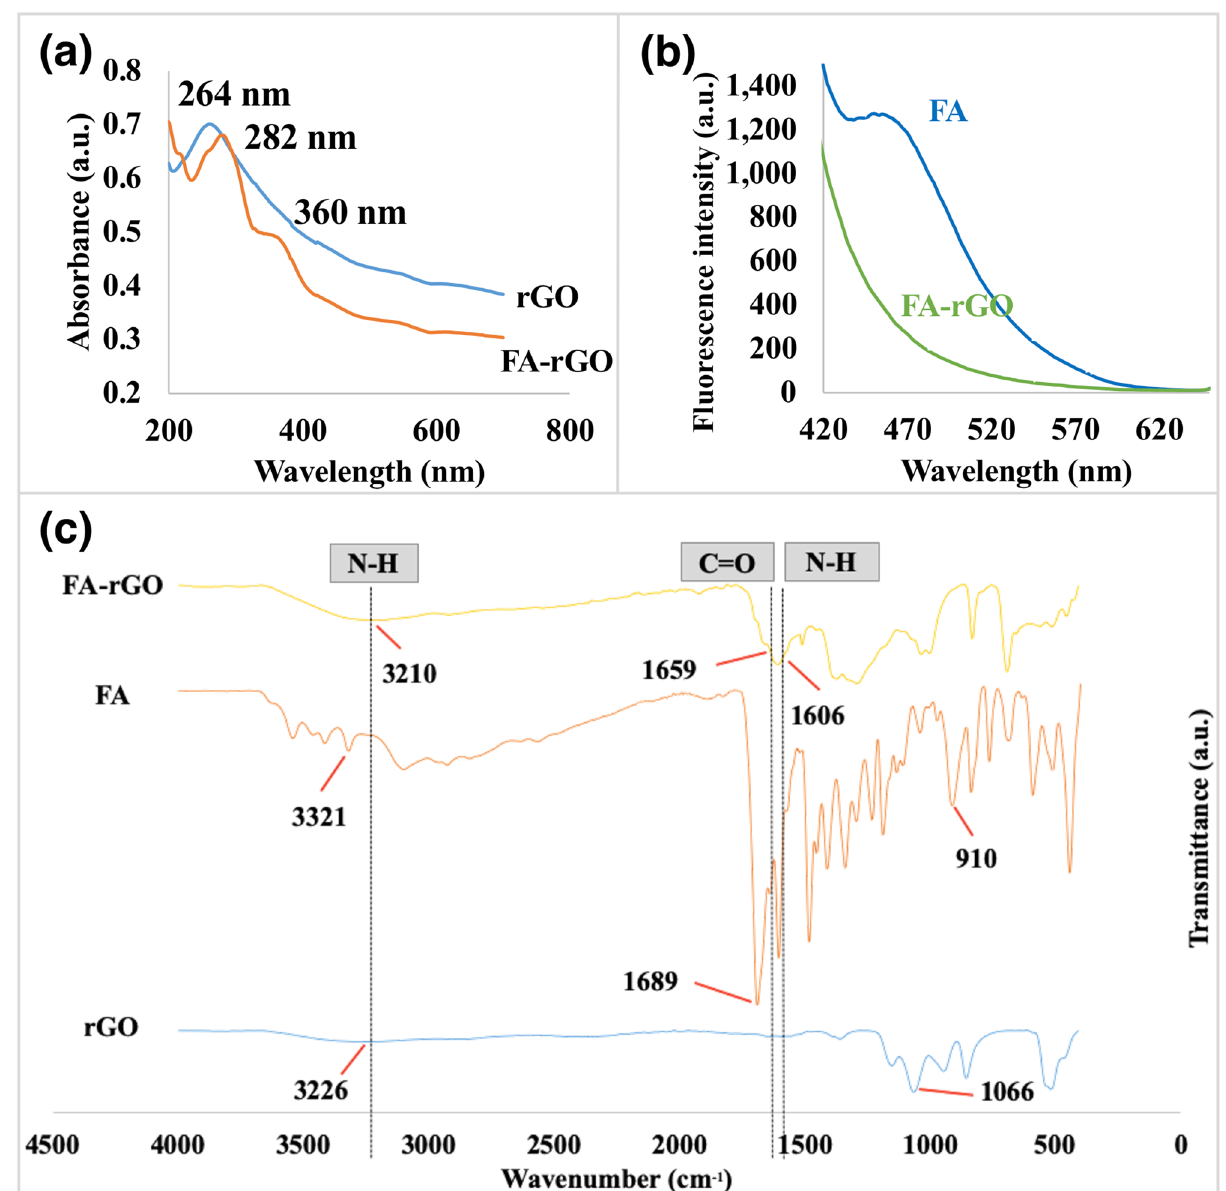
Figure 3. Characterization of FA-rGO. ( a ) UV–Vis spectra of rGO and FA-rGO in aqueous solution. ( b ) Fluorescence intensity of FA and FA-rGO at λ ex = 365 nm. ( c ) FTIR spectra of FA, rGO and FA-rGO measured in lyophilized